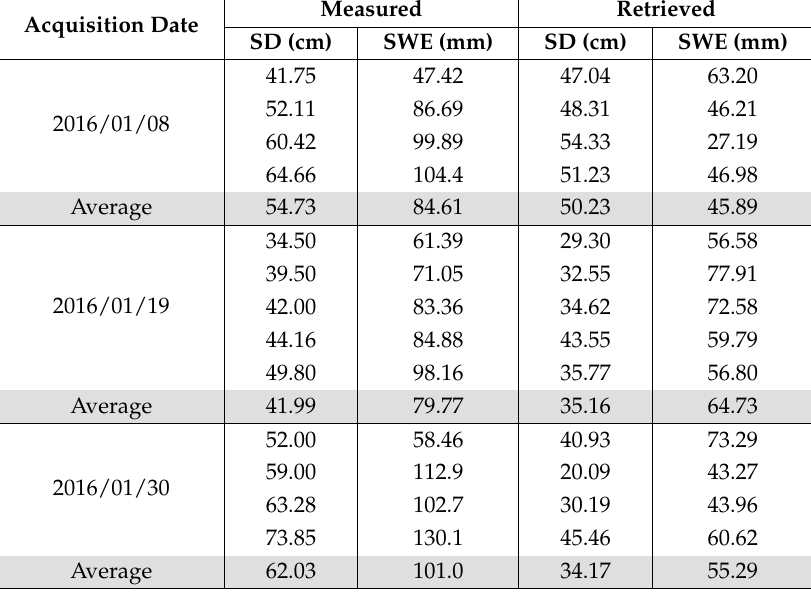
Table 3. Validation of snow depth (SD), and snow water equivalent